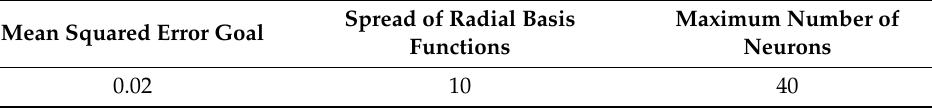
Table 6. Parameter characteristics used for RBF in this study.